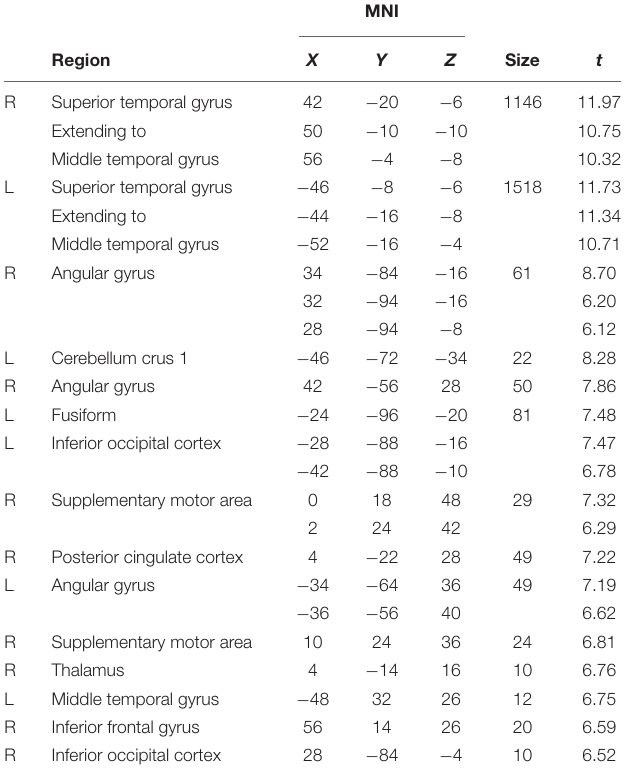
TABLE 1 | General effect of listening (LEARNING + LISTENING + MAINTENANCE).